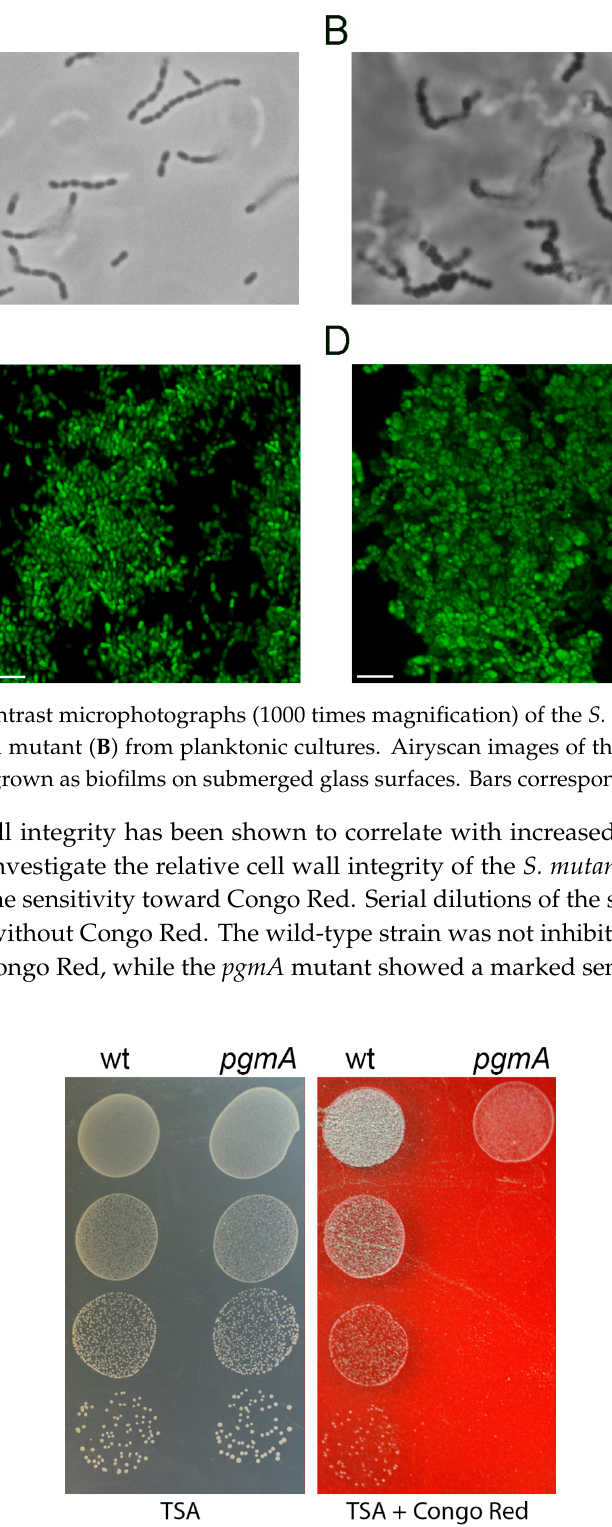
Figure 5. Congo Red susceptibility assay performed on the S. mutans wild type and pgmA mutant. Ten-fold dilutions of the respective strains were spotted on TSA plates with or without 0.2% Congo red, and the plates were subsequently incubated and